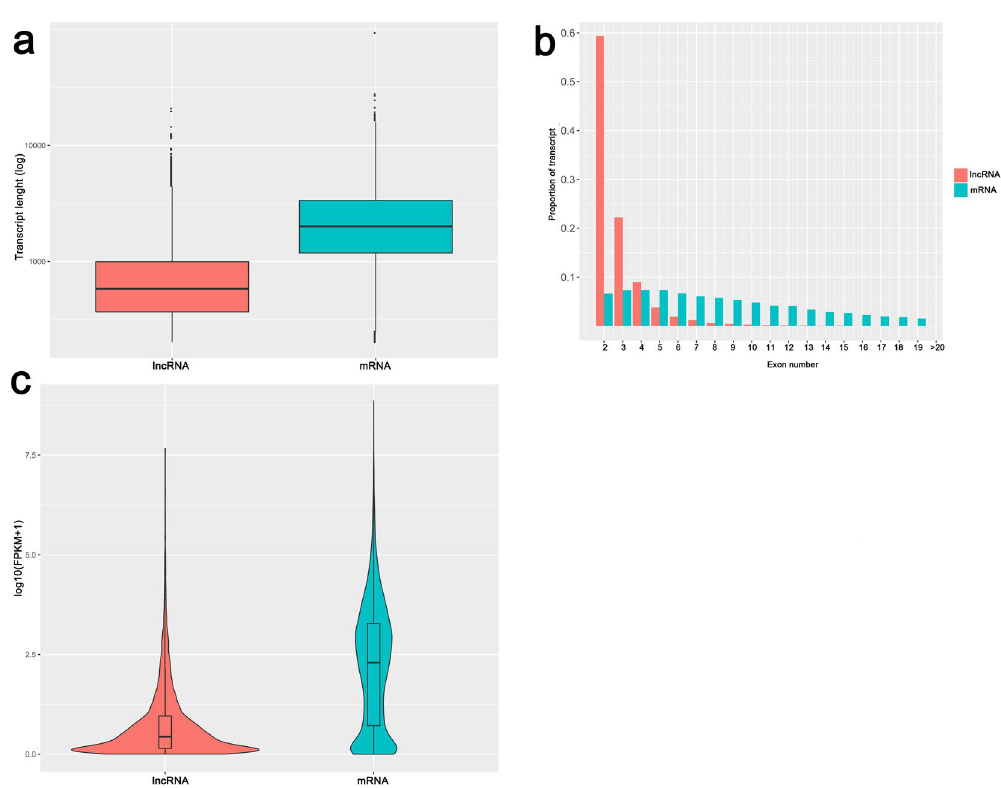
Figure 4. The distribution of transcript length, exon number and expression level of lncRNAs and mRNAs identified in UVJ samples of long-DF and short-DF hens. ( a ) Distribution of identified lncRNA and mRNA transcript lengths. ( b ) Distribution of exon numbers of lncRNA and mRNA transcripts. ( c ) Expression distribution of the lncRNA and mRNA